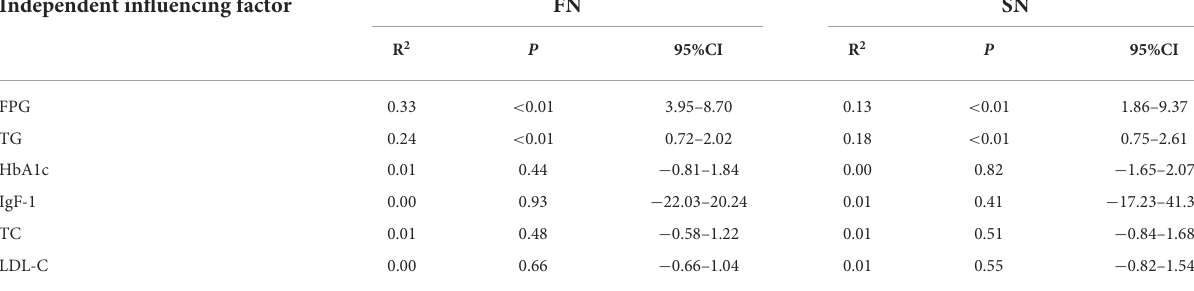
TABLE 4 Linear regression analysis of the SWV of FN and SN. Independent influencing